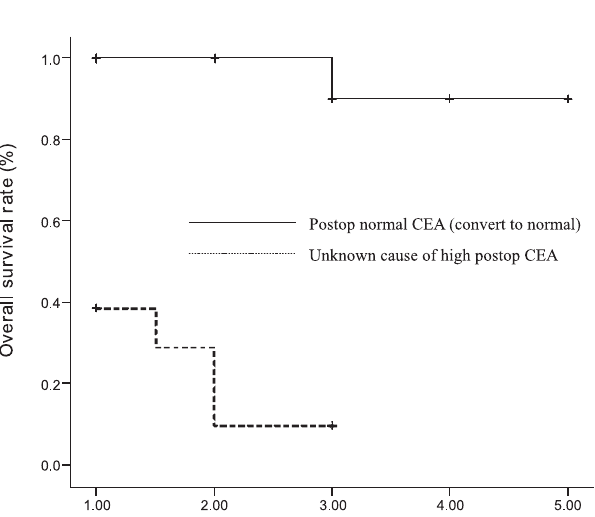
Figure 2 - Overall survival rates comparing patients whose serum CEA levels remained high for unknown reasons and those whose levels returned to normal after